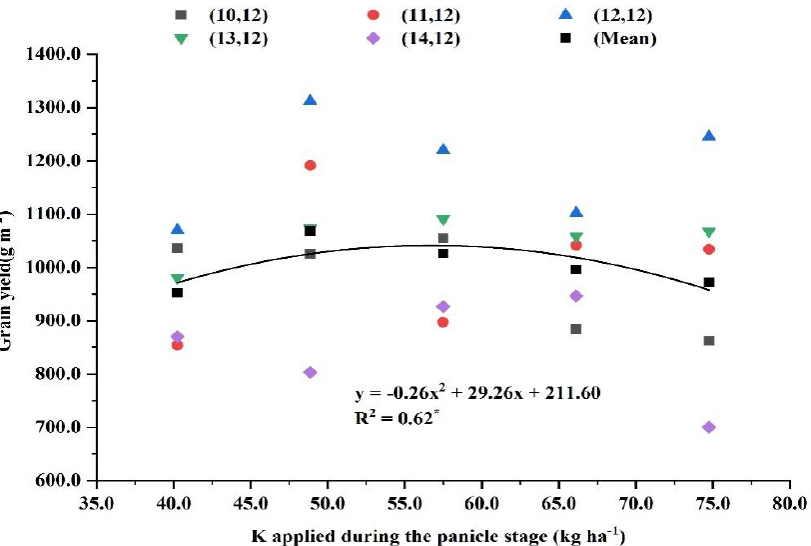
Figure 7. Correlation between yield and K fertilizer application at different leaf ages during the panicle stage. The (10,12), etc., represent the patterns of different applications of N and K at the panicle stage. * p <